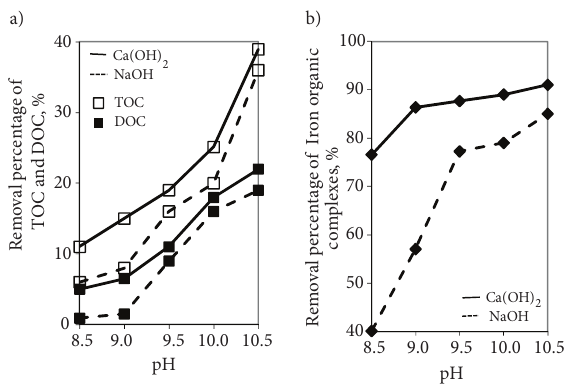
8. Effect of the type of alkalizing reagent: Ca(OH) 2 or NaOH on the amount of TOC and DOC (a) and iron organic complexes (b) removed from the water in the sedimentation